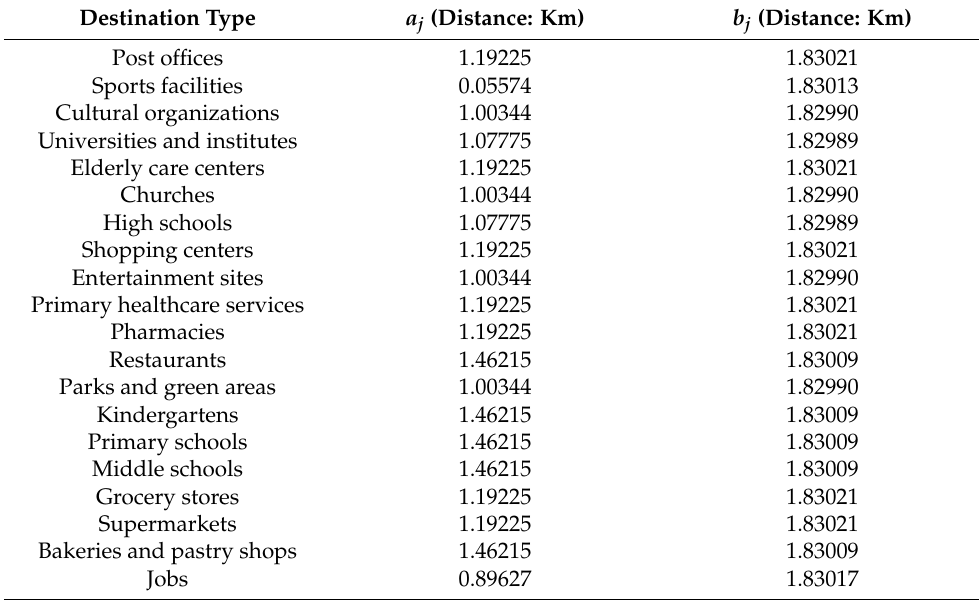
Table 2. Log-logistic parameters for